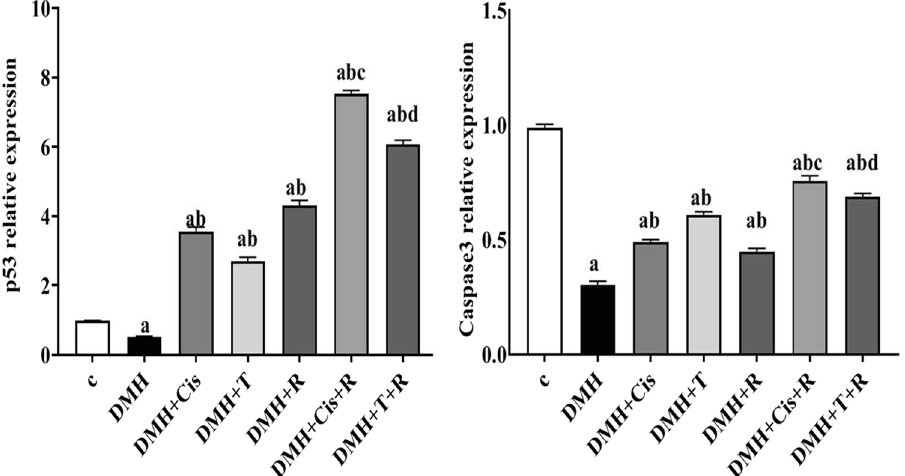
Fig. 6 Effect of thiophene derivative and low dose γ-irradiation on PPARγ and KRAS protein levels. C: control, DMH: dimethyl hydrazine, Cis: cisplatin, T: thiophene derivative, R: radiation. Values are the mean ± SEM (n = 3). a Significant change compared to the control group. b Signifi- cant change compared to DMH group. d Significant change compared to DMH + T